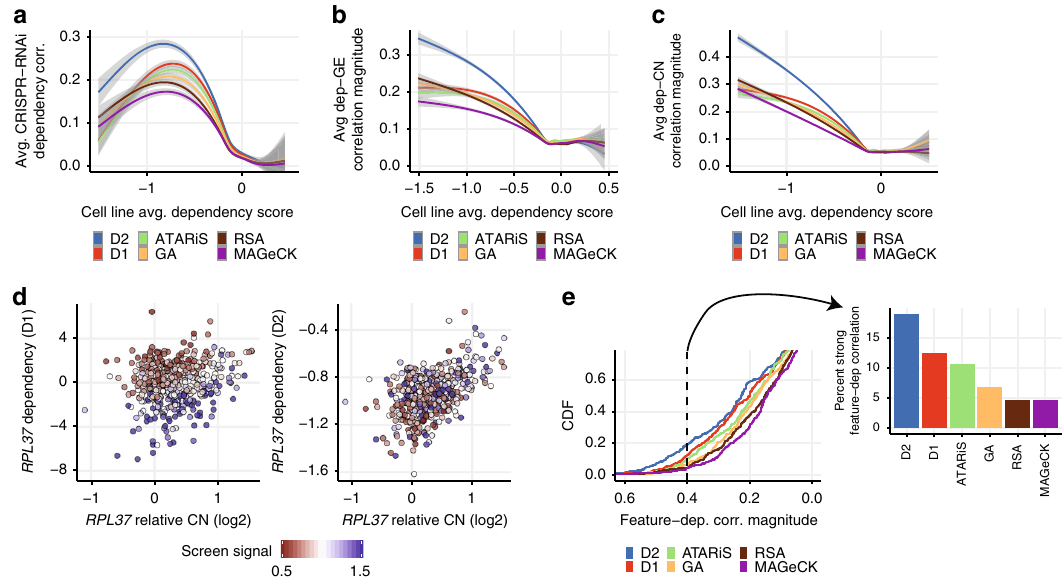
Fig. 4 D2 improves estimated dependency pro fi les, particularly for essential genes. a Average correlation between RNAi and CRISPR-Cas9 gene dependency pro fi les as a function of the across-cell-line average dependency score, using the Achilles dataset. Different colored curves and shaded regions show the smoothed conditional mean correlation, and 95% con fi dence intervals, obtained using different models for estimating RNAi gene dependencies. D2 gene dependency estimates show better average agreement with CRISPR-Cas9 dependency pro fi les compared to existing methods. b Average magnitude of correlation between each gene ’ s dependency and mRNA expression pro fi les (again for the Achilles dataset), plotted as a function of across- cell-line average gene dependency as in a . D2 dependency scores showed a stronger correlation with the gene ’ s own expression levels compared with existing methods. c Similar to b , showing stronger correlations between D2 dependency pro fi les and the genes ’ own relative copy number, particularly for genes which are more essential on average. d Scatterplot of RPL37 dependency vs. RPL37 relative copy number using D1 (left) and D2 (right) dependency scores. Color represents the screen signal parameter estimated (from D2) for each cell line. e A benchmark set of dependency-genomic feature relationships identi fi ed from CRISPR-Cas9 data (see Methods) was used to evaluate the extent to which Achilles RNAi dependency estimates recapitulated the same associations. Colored curves show the empirical distributions of correlation magnitude across these dependency-feature pairs for each model. D2 dependency estimates showed better agreement with benchmark genomic feature associations compared to existing methods. Bar chart at the right shows the fraction of dependency-feature pairs with correlation magnitude greater than 0.4 for each